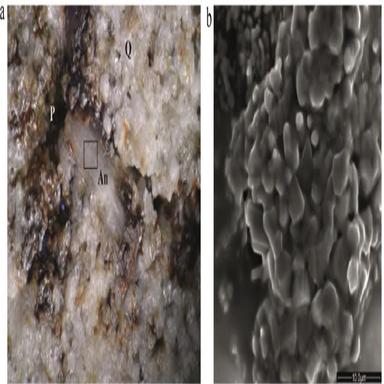
(a) Microstructure of a ceramic elaborated at 1450 C from andalusite rich schists: An (andalusite) Q (quartz) P (pore); (b) Scanning electron microscope (SEM) observation of the square-marked area in (a) using an optical microscope (OLYMPUS - SZX9).